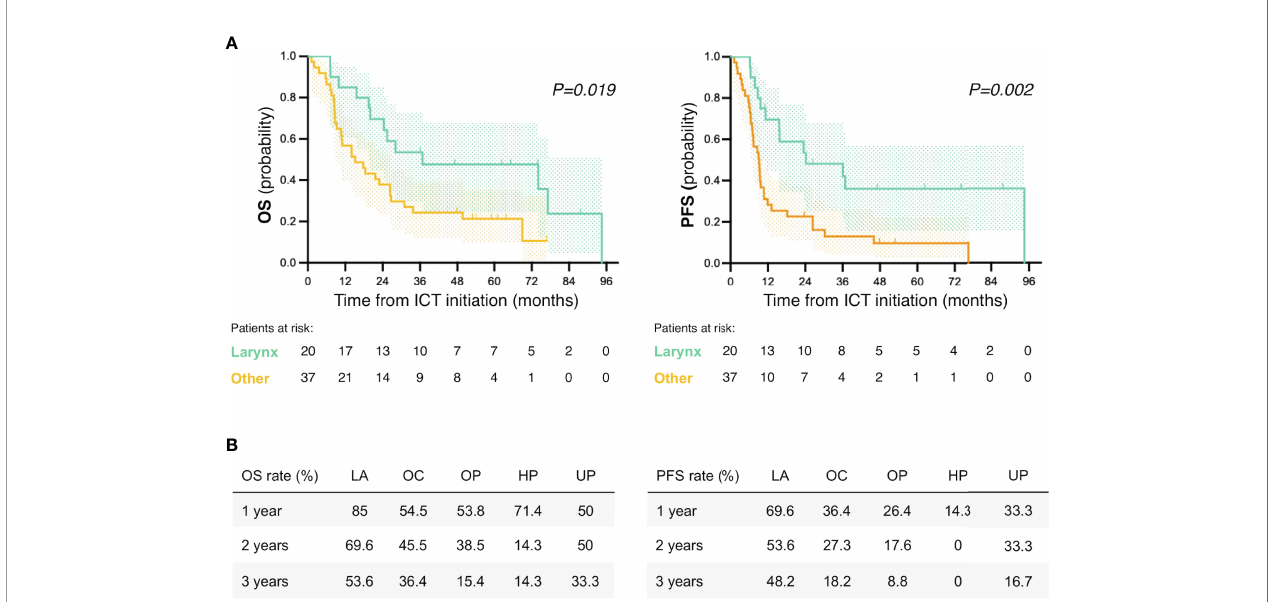
FIGURE 4 | Survival analysis according to primary tumor location. (A) Kaplan – Meier survival curves for overall survival (OS) and progression-free survival (PFS) of larynx vs. other primary tumor locations. p represents log-rank p -value for subgroup comparison. (B) OS and PFS rates by primary tumor location for the 1st, 2nd and 3rd year after ICT initiation. ICT, induction chemotherapy; LA, larynx; OC, oral cavity; OP, oropharynx; HP, hypopharynx; UP, unknown